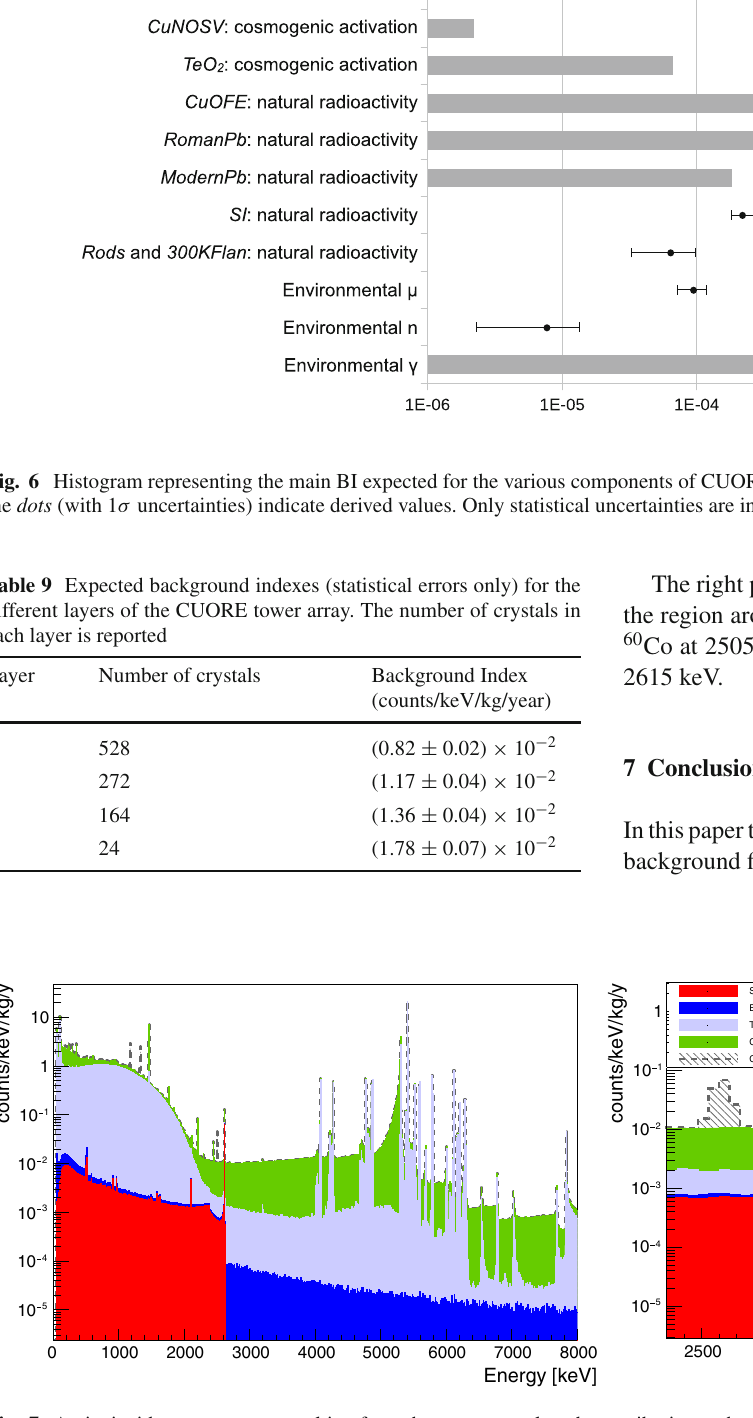
tribution to the shape of the spectrum, the 40 K in TeO 2 and in CuNOSV as well as the 130 Te 2 νββ decay contributions are also included. The region around the ROI (i.e. the interval 2470–2570 keV) is shown in the right panel . Two peaks are visible, they are: the 60 Co line at 2505 keV line and the 208 Tl line at 2615 keV (see text for more